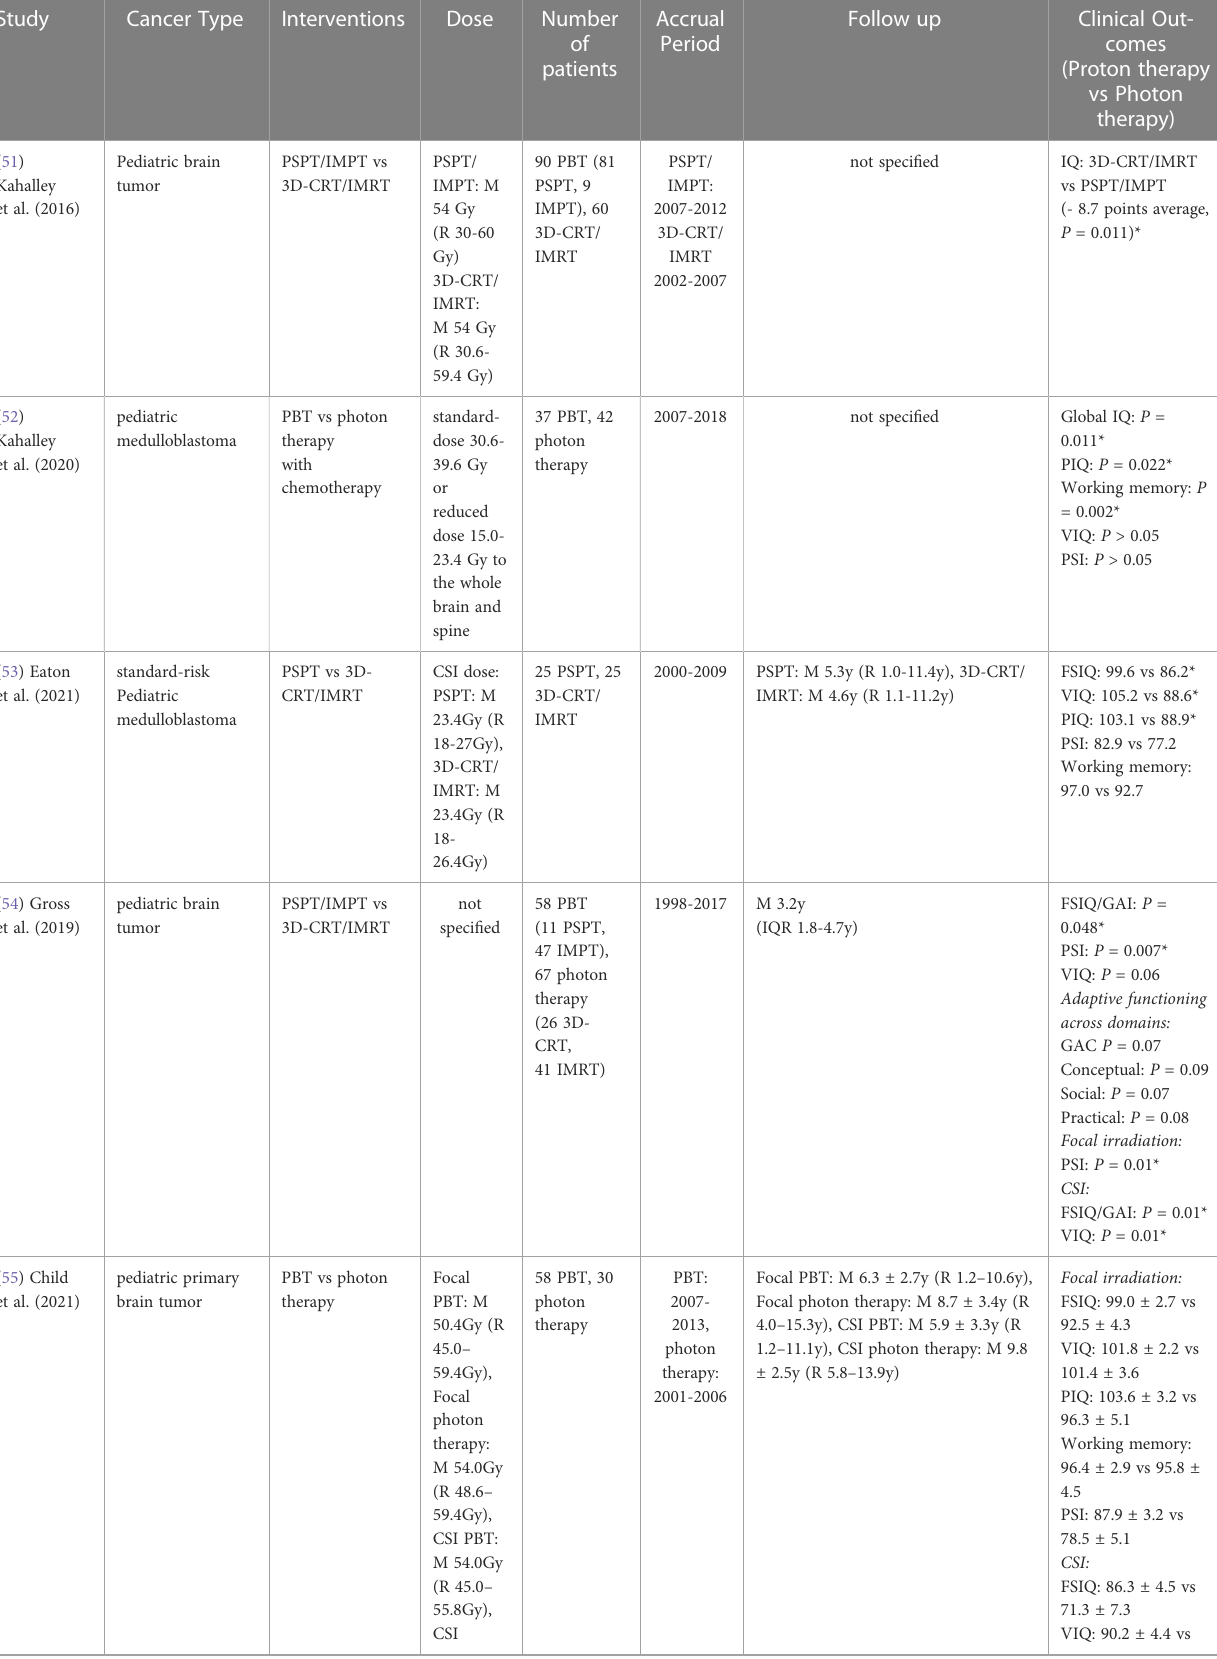
TABLE 7 Non-randomized clinical studies of proton versus photon radiation therapy – pediatric CNS